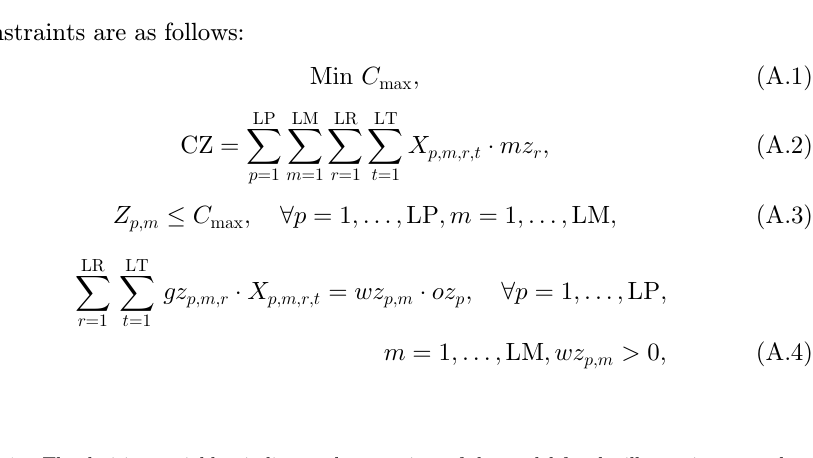
Table A.1. The decision variables, indices and constraints of the model for the illustrative example.